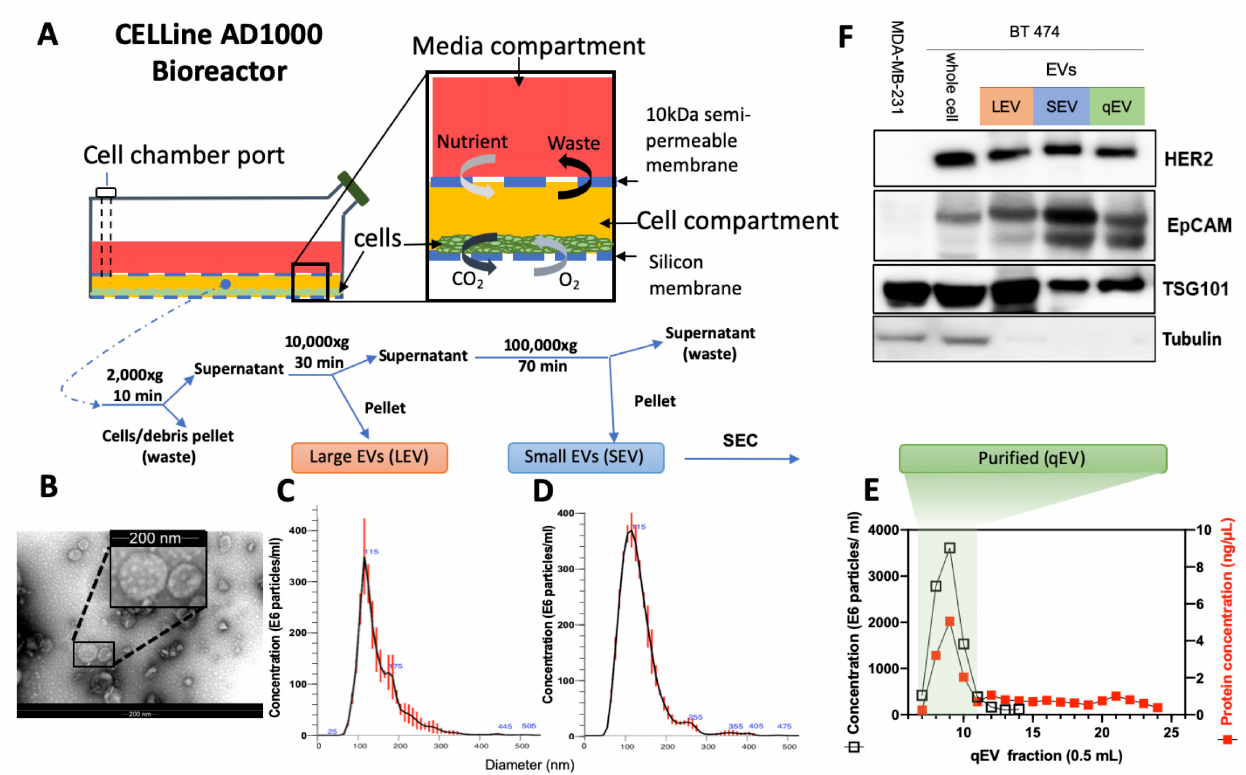
Figure 1. Purification and characterisation of BT-474 EVs. ( A ) experimental procedure employed for extracellular vesicle (EV) production, isolation, and purification; ( B ) transmission electron microscopy image of a small EV; ( C , D ) hydrodynamic diameter distribution profiles of isolated large and small EVs measured by nanoparticle tracking analysis (NTA) wherein red vertical lines and blue numbers denote standard deviation and particle diameters at specific peaks, respectively; ( E ) EV concentration (empty squares) determined by NTA, and protein levels (filled squares) determined by BCA assay of fractions acquired during separation on a qEV Original size exclusion chromatography (SEC) column; and ( F ) immunoblot with antibodies specific for HER2, EpCAM, α-tubulin and TSG101 proteins. Tetraspanin TSG101 is a loading control expected to be present in both EVs and cells. The α-tubulin should be present only in the cell lysates but not in purified EVs. MDA-MB-231 cell lysate serves as the negative control for HER2 and EpCAM proteins. Representative images/data from three independent experiments were shown in B – F